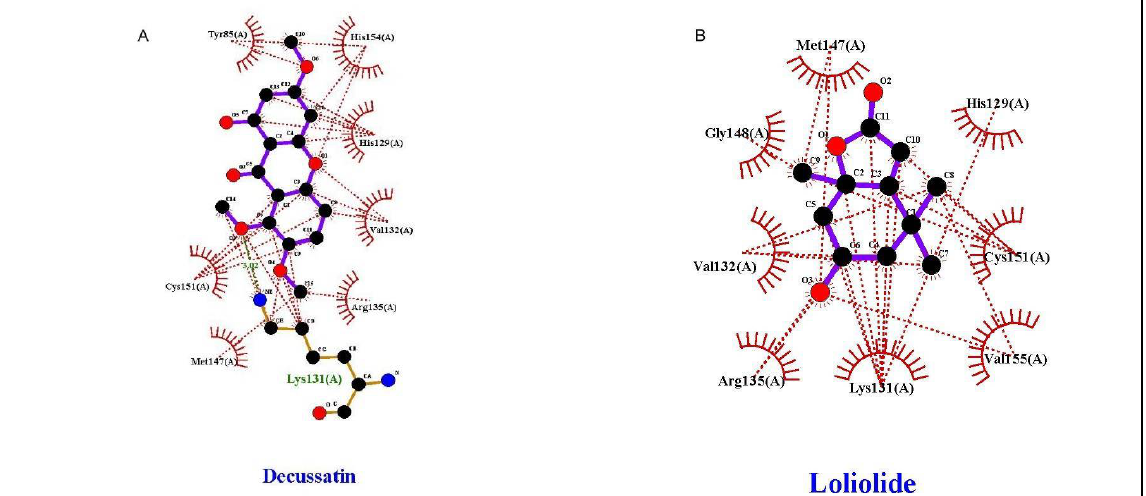
Figure S3: The two-dimensional illustrations of the interaction analysis of the individual ligands with the BTB domain of the Keap1 protein as obtained from